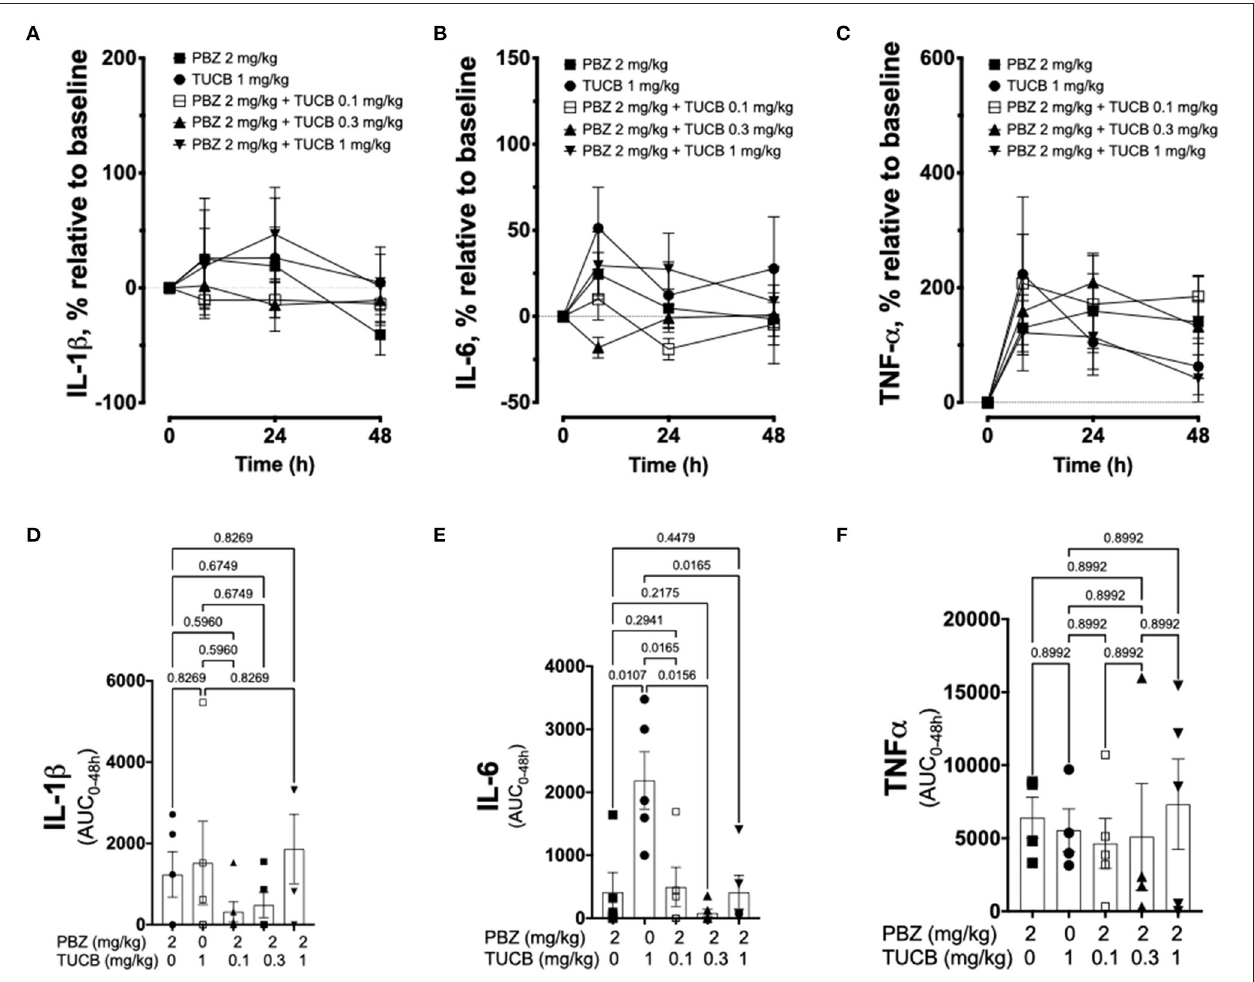
FIGURE 4 | Cytokine response associated with synovitis during inhibition of soluble epoxide hydrolase (sEH) and cyclooxygenases (COX). Forty-eight-hour time course (top row) and aggregate area under curve (AUC, bottom row) for synovial fluid concentrations of interleukin (IL)-1 β (A,D) , IL-6 (B,E) , and tumor necrosis factor (TNF)- α (C,F) in an equine synovitis model induced by intra-articular injection of lipopolysaccharide (LPS; 3 µ g) into the radiocarpal joint ( n = 6 horses) as measured using ELISA techniques. Horses were treated intravenously with the sEH inhibitor trans -4-{4-[3-(4-Trifluoro-methoxy-phenyl)-ureido]-cyclohexyloxy}-benzoic acid (TUCB), the non-selective COX inhibitor phenylbutazone (PBZ) or both, at the indicated doses marked above (top row) or below (bottom row) the graphs, at the same time as the intra-articular LPS injection. Top row: Data are shown as mean ± SEM. Bottom row: Data are shown as individual values (symbols) and mean ± SEM (columns), and p -values are shown above each respective comparison (Mixed-effects model corrected for multiple comparisons by controlling the False Discovery